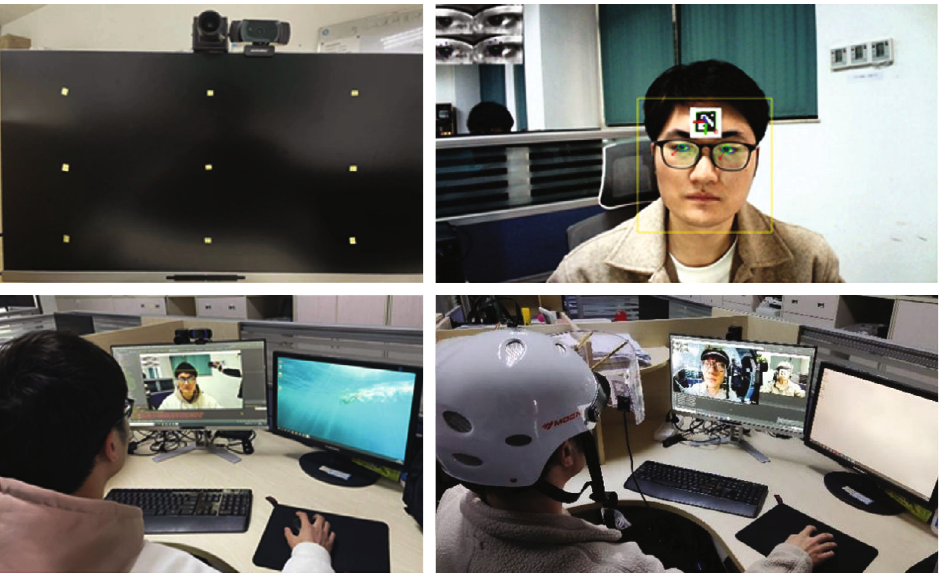
Figure 8: Gaze estimation under lab environment. Upper left: nine markers on the screen. Upper right: a subject sat in front of a screen and looked at a marker on the screen. Lower left: the eye feature points are extracted from the webcam and 3D gaze direction is estimated. Lower right: the eye feature points are extracted from the proposed HMD helmet and 3D gaze direction combined with helmet orientation is